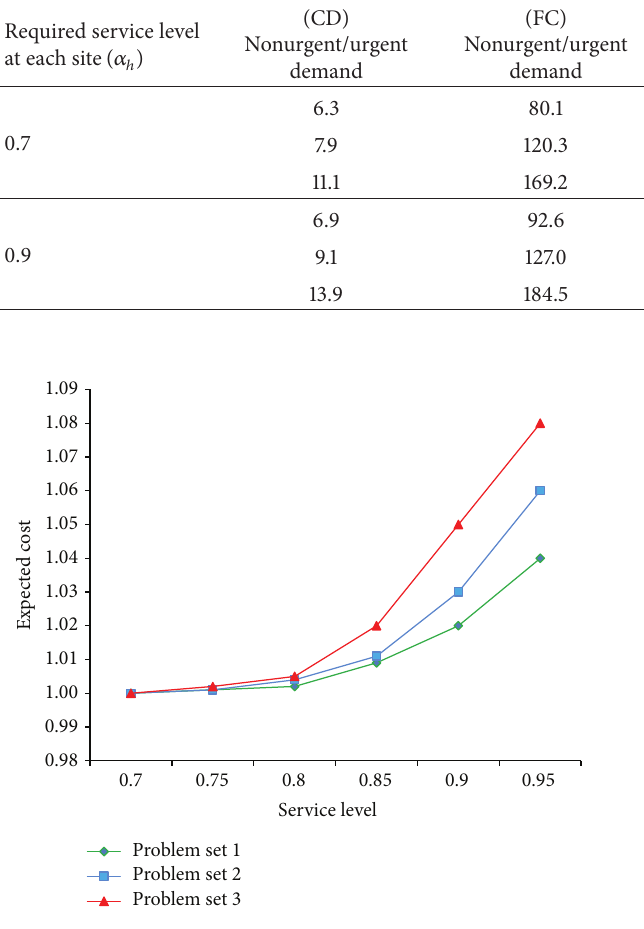
Figure 4: Relative cost against service level at each site ( 𝛼 ℎ ) under MP policy, problem sets 1, 2, and 3. Note: the total cost is represented relative to the cost at service level equal to 75%.